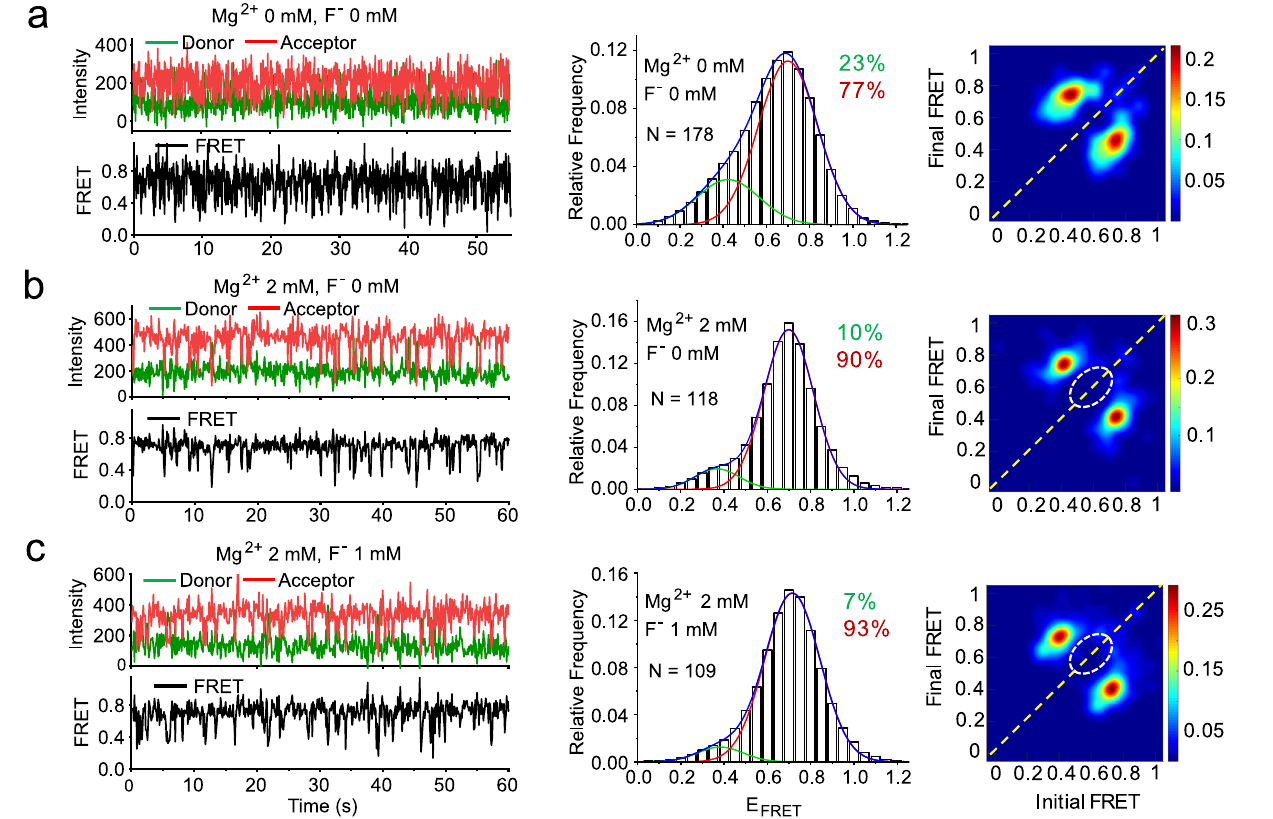
Fig. 3 U48A mutation in RNA64 leads to loss of the SD state. Representative smFRET traces, histograms and TODPs for the U48A mutant ( a ) in the absence of Mg 2 + and F - ; ( b ) in the presence of 2 mM Mg 2 + alone; and ( c ) in the presence of both 2 mM Mg 2 + and 1 mM F - . The percent population of all fi tted peaks are shown in respective colors in each histogram panel. The dashed white circle in the TODP highlights the absence of the SD state. The number of molecules that were analyzed is indicated by “ N ”